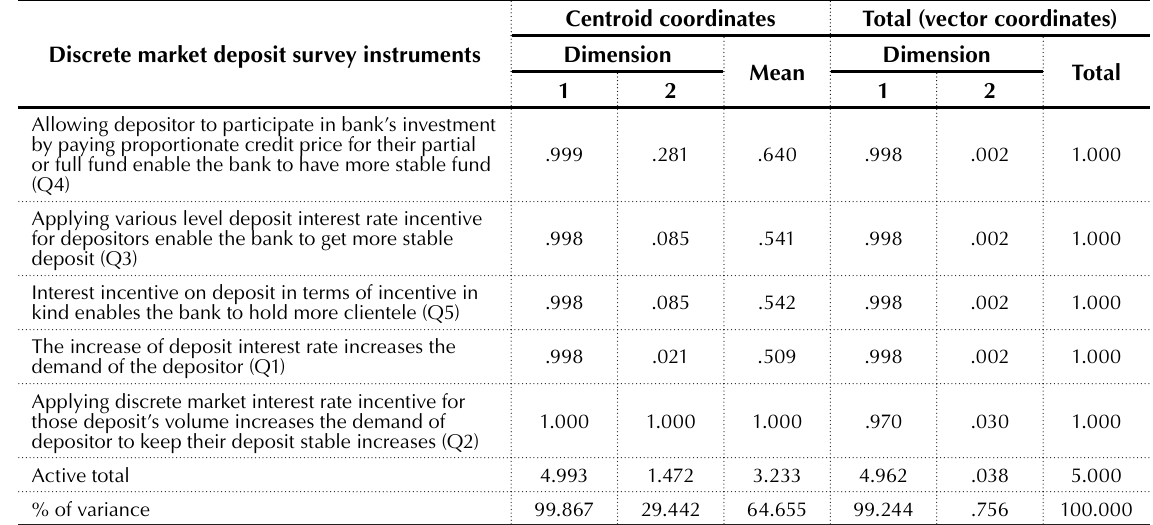
Table 15. Variance accounted for